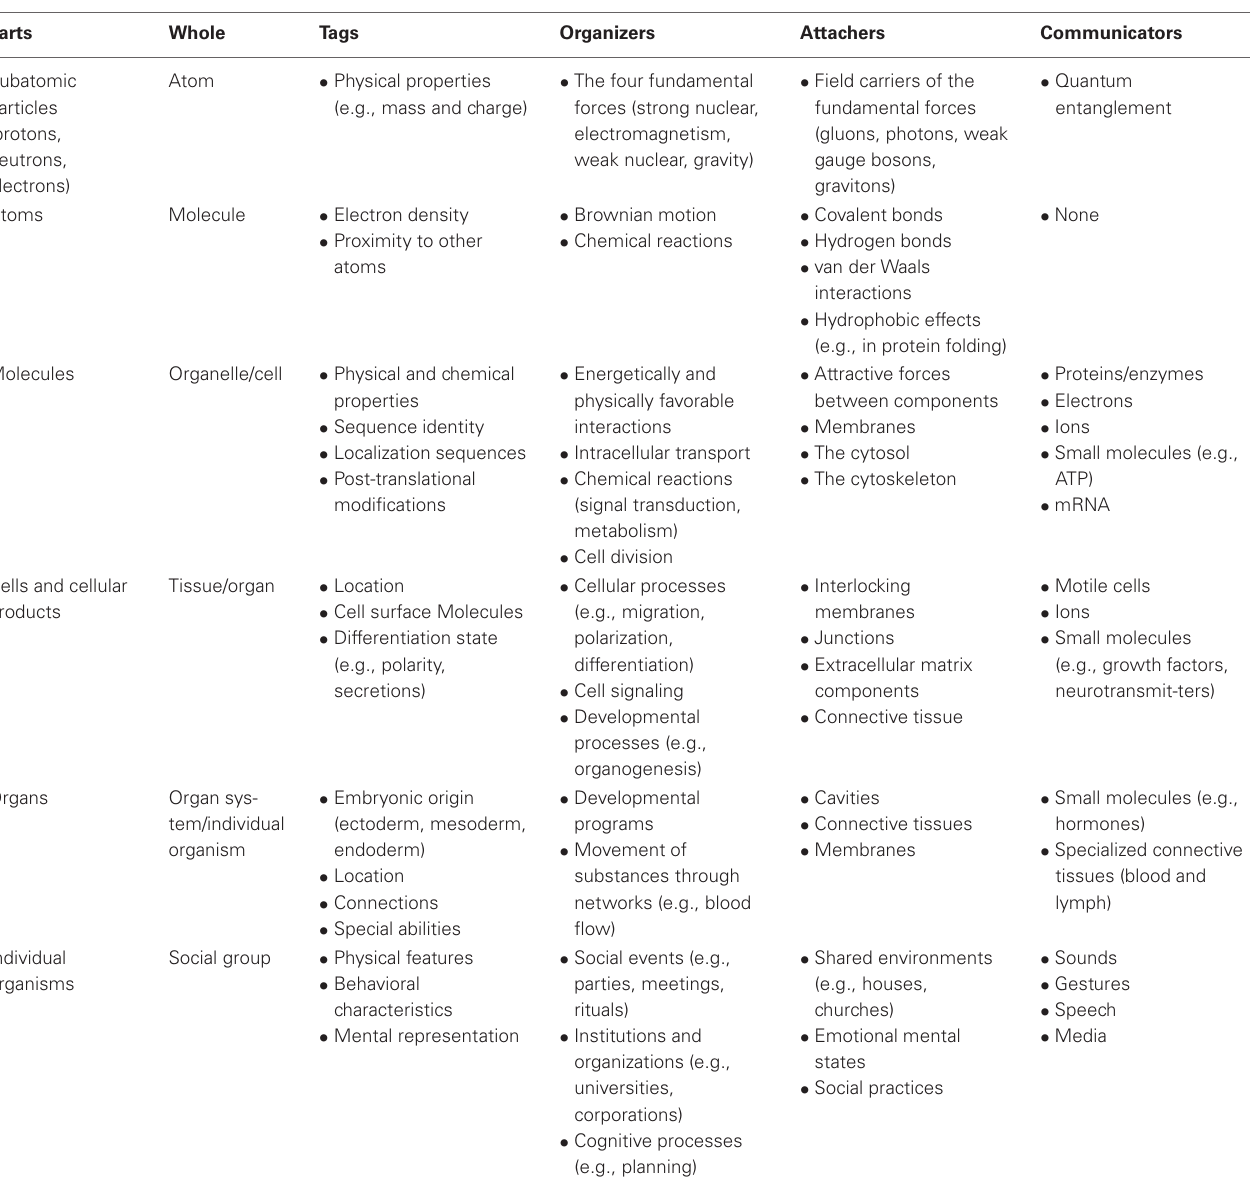
Table 1 | Examples of major tags, organizers, attachers, and communicators for various levels of